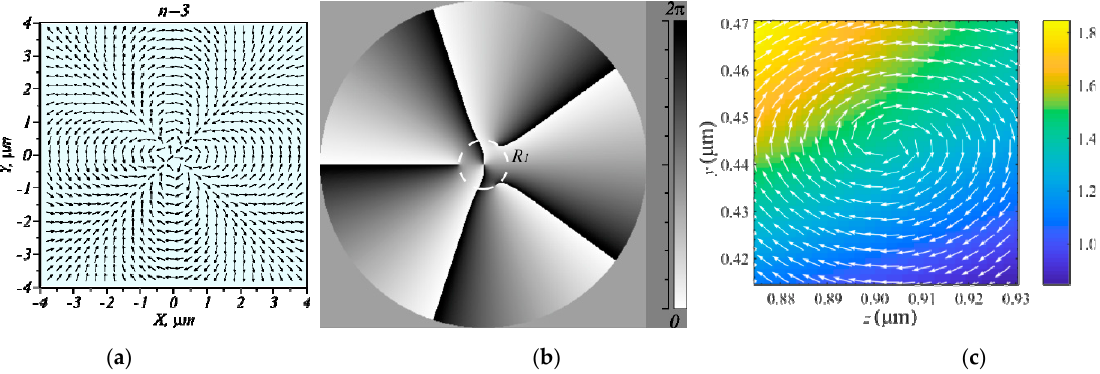
Figure 7. Examples of critical points (singularity points): ( a ) V-point at the center of the CVB field with order n = 3 (arrows show the directions of local linear polarization vectors); ( b ) phase (from zero to 2 π ) of an optical vortex with the center of a fifth-order phase singularity (topological charge is 5); and ( c ) the point of uncertainty of the energy flow direction in the meridional plane at the focus of the CVB with the order n = 2 (Figure 4).